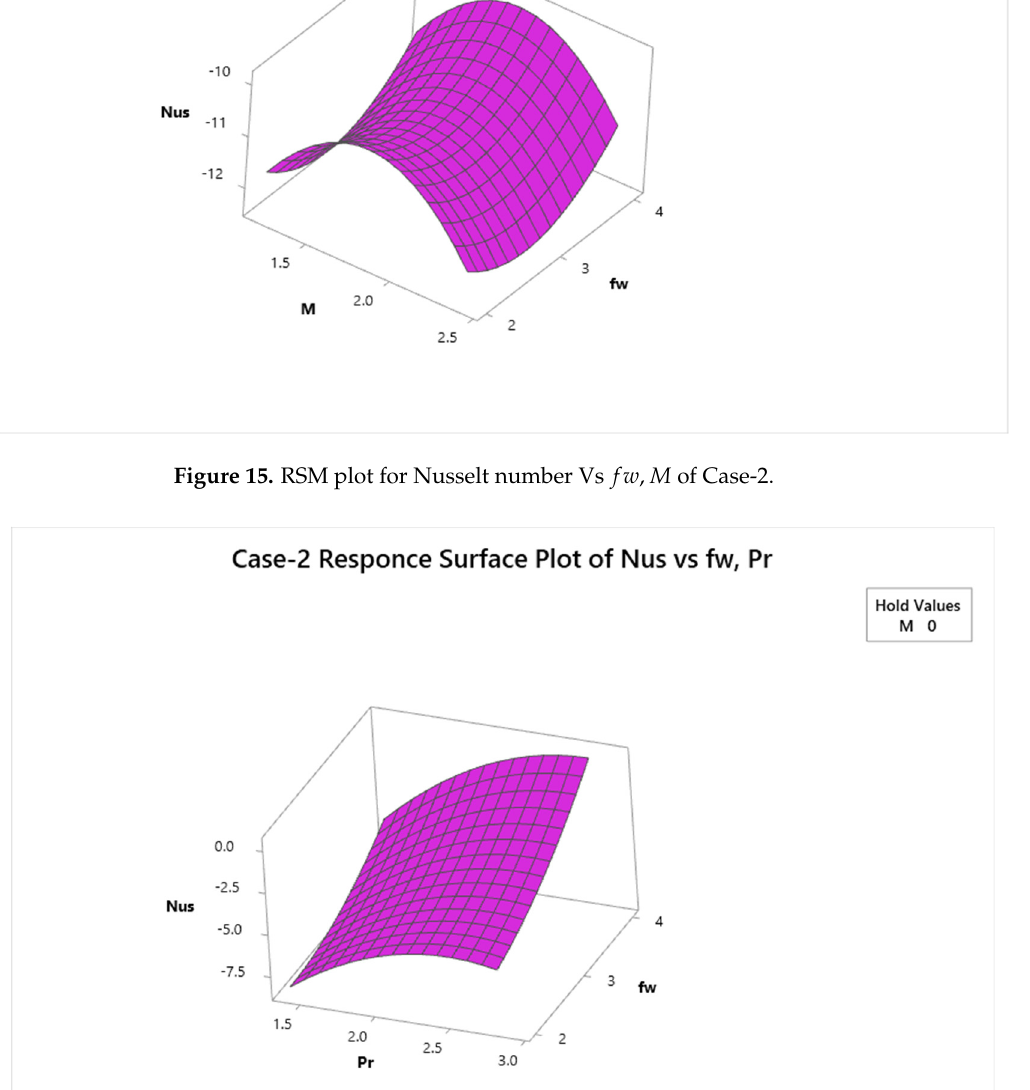
Figure 16. RSM plot for Nusselt number Vs ,Pr fw of Case-2.